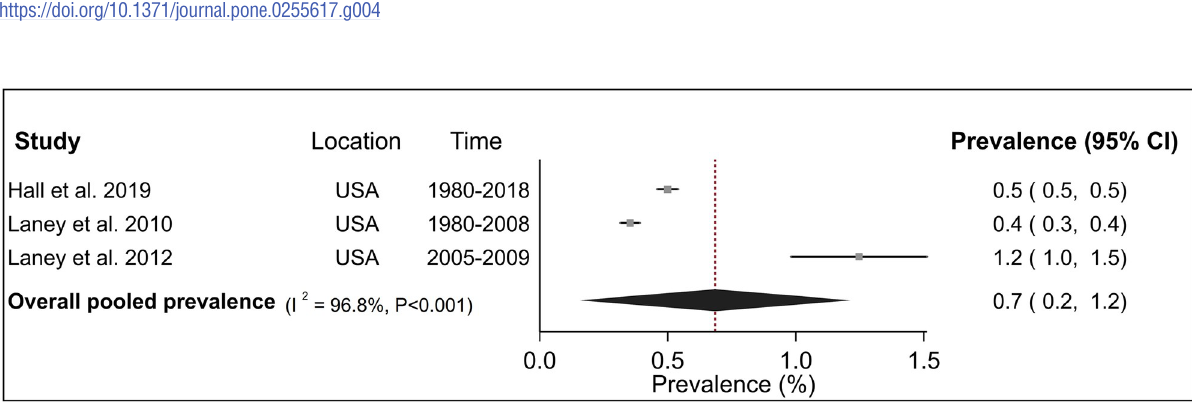
Fig 5. Forest plot from meta-analysis for overall prevalence of r-type opacities in the United States (USA). The red dashed line corresponds to the overall effect size to guide the eye.